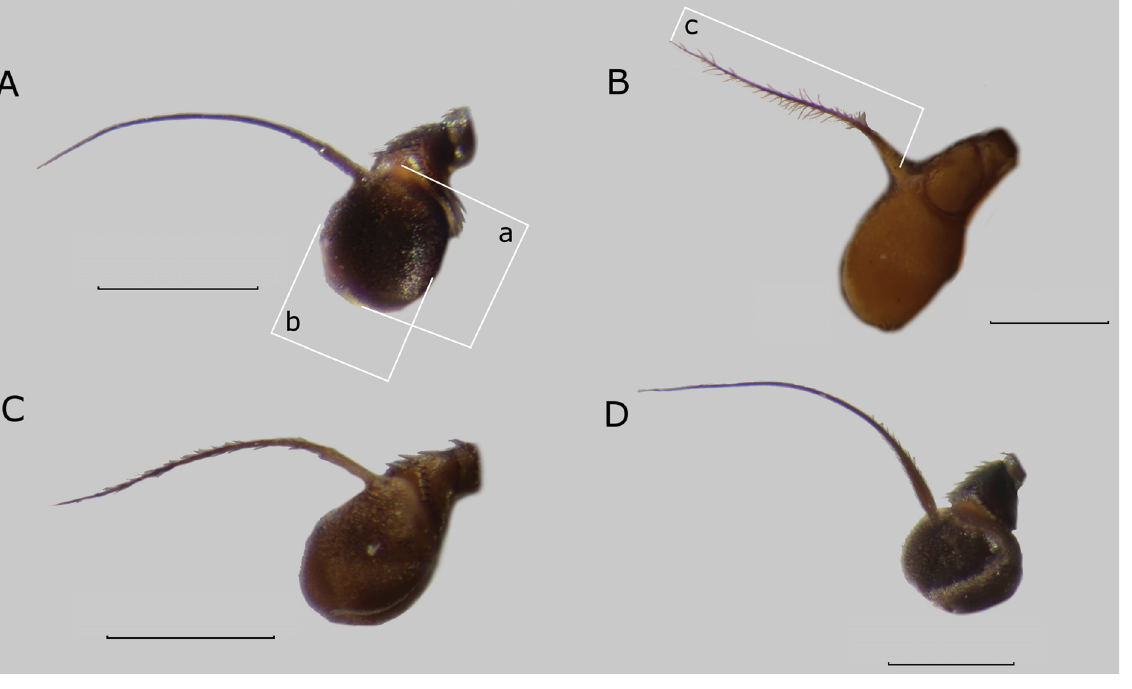
Fig. 43. Baso fl agellomere, lateral view. A . Sphegina (Asiosphegina) dentata sp. nov., paratype, ♂ , Taiwan. B . S. (A.) distincta sp. nov., paratype, ♂ , Viet nam. C . S. (A.) hauseri sp. nov., paratype, ♂ , Nepal. D . S. (A.) tricoloripes Brunetti, 1915, ♀ , India. Abbreviations: a = length of baso fl agellomere; b = width of baso fl agellomere; c = length of arista. Scale bars 0.25